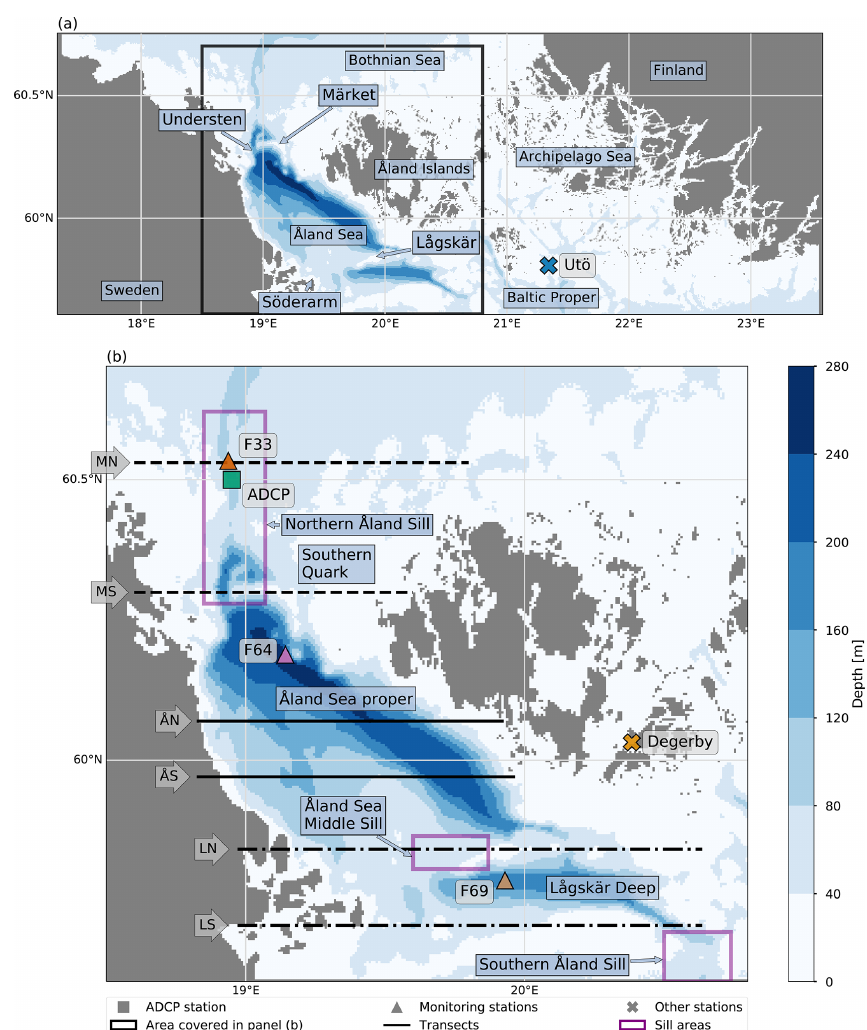
Figure 1. (a) Model domain and bathymetry. The main focus area of this study is shown with a rectangle. In addition, several geographic references are displayed. (b) A more detailed map of the main focus area. Sub-basins and sill areas relevant for the analysis are shown. Furthermore, the locations of stations and transects mentioned in the text are